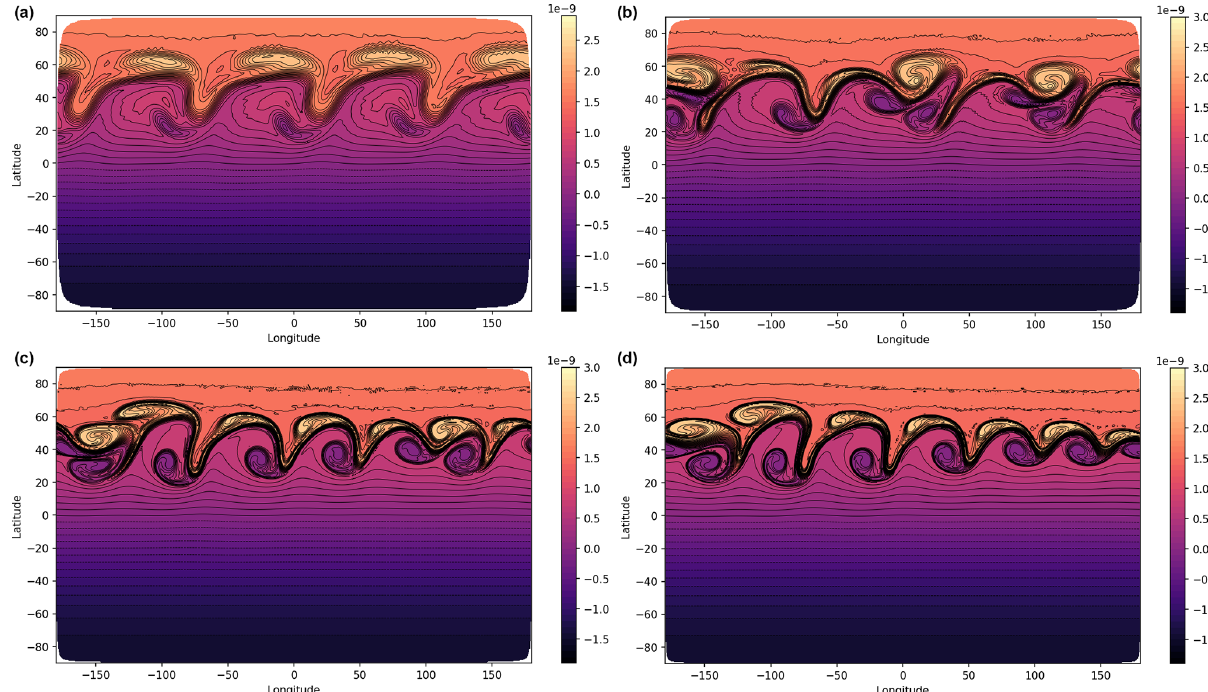
Figure 8. The potential vorticity q after 6d for the Galewsky instability test. Panel (a) shows the C48 solution, panel (b) shows the C96 solution, panel (c) shows the C192 solution, and panel (d) shows the C384 solution.